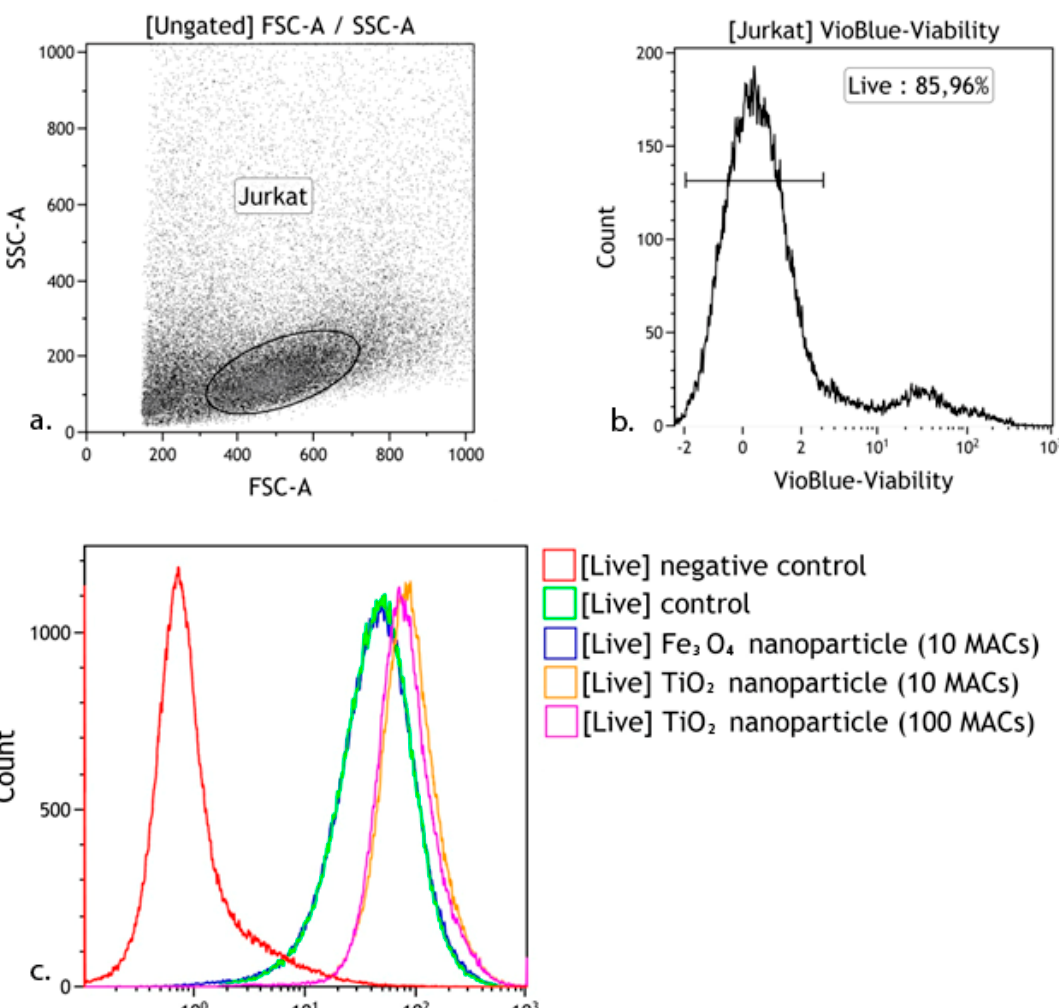
Figure 2. Algorithm for determining intracellular levels of ROS after 24 h in culture with the addition of a nanoparticle suspension. ( a ) Jurkat gating based on a forward scatter (FSC) vs. side scatter (SSC) plot; ( b ) The analysis was carried out using gating of Jurkat cells. The abscissa axis is the fluorescence intensity of antibodies against Viability Fixable Dye; the ordinate is the number of cells; ( c ) Evaluation of the production of reactive oxygen species.